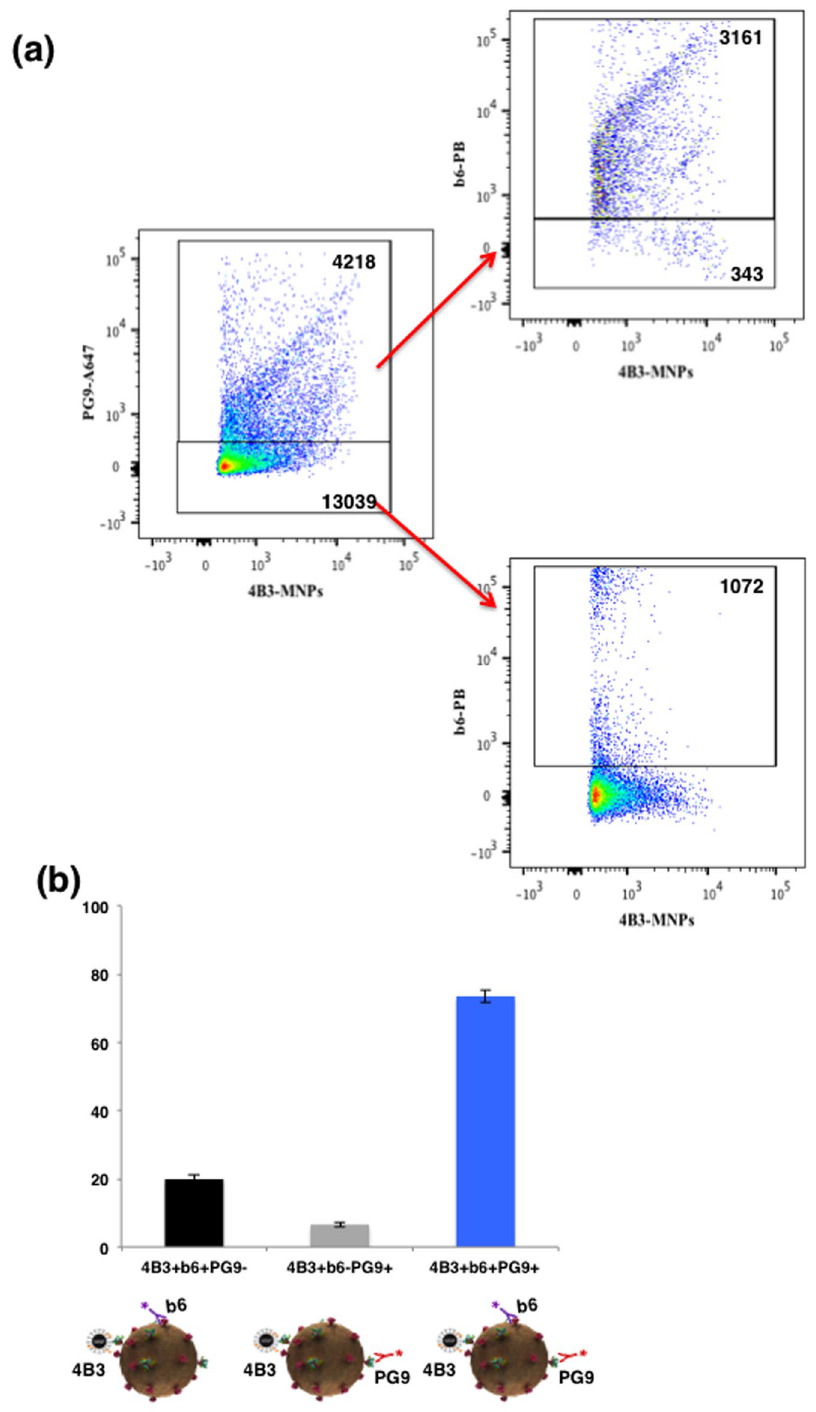
Figure 5. Flow virometry of HIV-1 BaL virions captured with 4B3-MNPs. ( a ) Virions were captured with 4B3- MNPs and stained with two antibodies: AlexaFluor 647-labeled PG9 antibodies and Pacific Blue-labeled b6. Left panel: Virions were captured with 4B3-MNPs and stained with PG9; upper right panel: 4B3-MNP-captured virions positive for PG9 and stained with b6; lower right panel: 4B3-MNP-captured virions negative for PG9 and stained with b6. Indicated are the numbers of events. A representative experiment out of three is shown. ( b ) Distribution of 4B3-captured virions positive for PG9 and b6. Each bar represents mean ± SEM of three